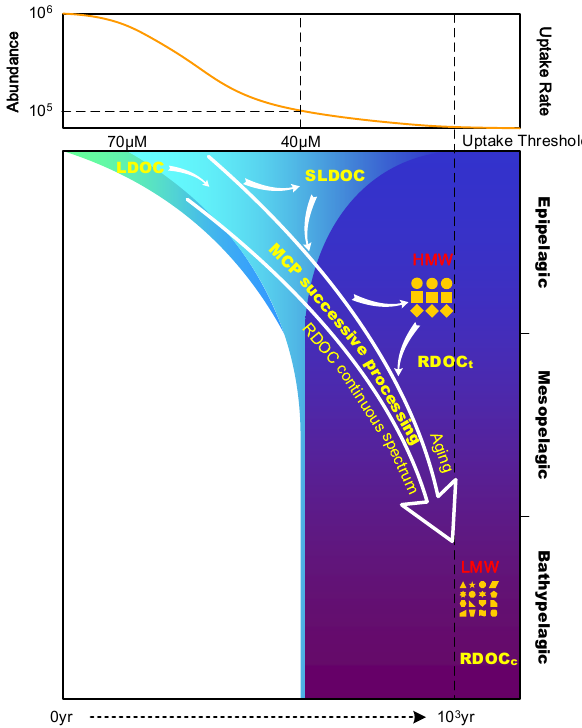
Figure 1. Linking RDOC at multiple dimensions: temporal (age) and spatial (depth) transformations of RDOC. Lower panel: succes- sive microbial processing of organic carbon results in the generation of RDOC of different recalcitrance and different potential residence time; MCP – microbial carbon pump; RDOC t – RDOC compounds that are resistant to microbial consumption in certain environments, but subject to further cleaving and decomposition when the situation changes; RDOC c – composed of diverse small molecules which are inaccessible to microbial uptake due to their low concentration. Up- per panel: microbial response (in terms of abundance or uptake rate) to DOC availability as a reference to conceptualize the microbial uptake threshold for RDOC c , microbial abundance corresponding to DOC concentrations of 40µM in the deep and 70µM in the sur- face oceans; LDOC – labile DOC, a fraction of DOC, which is im- mediately accessible to microbial utilization; SLDOC – semi-labile DOC, a fraction of DOC, which resides mainly in the upper layer but which becomes labile when transported to deep